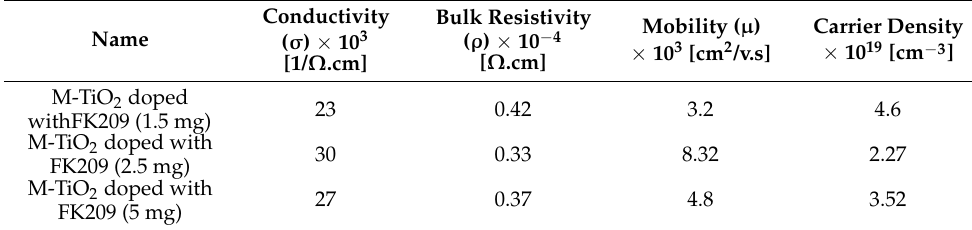
Table 3. Electrical properties of the M-TiO 2 doped with different concentrations of